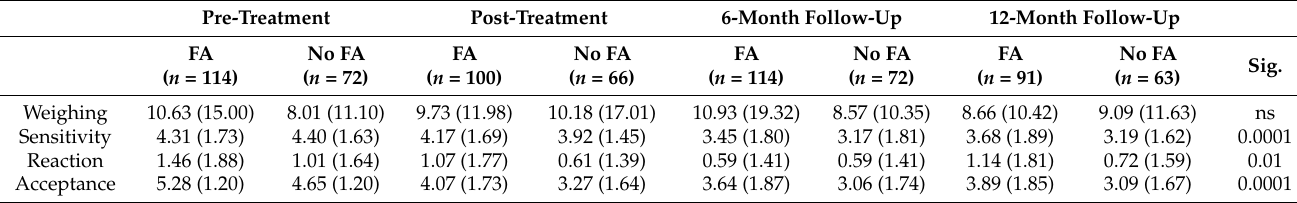
Table 2. Means and standard deviations of weighing variables by Yale Food Addiction Scale Group.